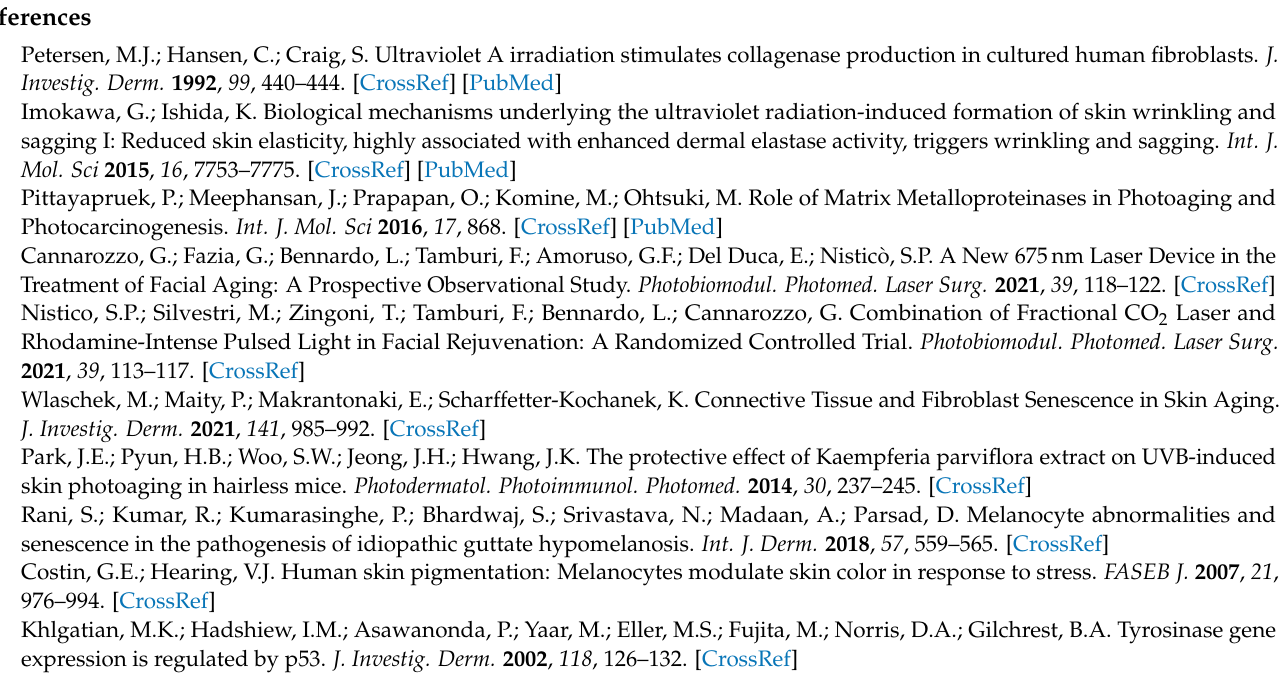
Table S1: List of antibodies for Western blotting (WB), immunohistochemistry (IHC), and immuno- cytochemistry (ICC). Table S2: List of primer for quantitative real time polymerase chain reaction (qRT-PCR). Figure S1: Regulation of melanin amount ratio by various combinations of niacinamide, vitamin C, and PDRN in the α -MSH-treated human melanocytes. Figure S2: Schematic diagram of the in vitro experiment used in this study. Figure S3: Regulation effect on the expression of NRF2 and HO-1 by HQ, PDRN, and PVN treatment in the UV-B-radiated human keratinocytes and animal skin. Figure S4: Regulation of the expression of p53 and MITF by HQ, PDRN, and PVN treatment in UV-B-radiated animal skin. Figure S5: Regulation of the expression of NF- κ B by HQ, PDRN, and PVN treatment in the CM-treated human fibroblasts and animal skin. Figure S6: Regulation of the expression of COL1A1, fibrillin 1/2, and fibulin 5 by PVN treatment in UV-B-radiated animal